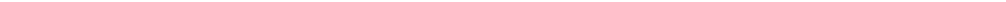
(see fi gure on previous page) Fig. 2 Bivalent chromatin domains in hPGCs. a Heatmaps showing the distribution of H3K4me3 (red) and H3K27me3 (blue) pro fi les around TSS (± 2 kb) in male and female hPGC samples at early and late stage. Signals are sorted by H3K4me3 pro fi les at each stage and colors indicated ChIP-seq RPM. b Line plots showing the global dynamics of H3K4me3 and H3K27me3 covered promoters in male and female hPGC samples at indicated time points. c Left, immuno fl uorescence analysis for H3K27me3 in male and female genital ridge cryosections at indicated time points. The nuclei of c-KIT positive hPGCs are indicated by white dotted line. Scale bars, 10 μ m. Right, analysis of relative intensity of H3K27me3 between indicated samples. Each dot represents the relative fl uorescence intensity of a single nucleus. Data are represented as the means ± SEM ( n ≥ 18 single nuclei). d Magni fi ed immuno fl uorescence images showing female hPGCs enriched with strong punctuated H3K27me3 signals. The nuclei of individual c-KIT positive hPGCs are marked by white dotted line. e Pie plots showing the proportion of bivalent (green) and H3K27me3-only (blue) promoters within all the H3K27me3 covered promoters in hPGC samples of both sexes at early and late stage. f Boxplots showing the H3K4me3 pro fi les and gene expression levels on promoters with (w/) and without (w/o) H3K27me3 enrichment at early and late stage of male and female hPGCs. H3K4me3 signals at H3K27me3 covered promoters were much higher than those at non-H3K27me3 covered promoters. And genes covered by H3K27me3 signals showed a much lower expression level. Expression levels are represented as FPKM and pro fi les are calculated as ChIP-seq RPM. g Genome browser view of H3K4me3 and H3K27me3 pro fi les (shaded in light purple) on representative bivalent gene SYCP1 of both sexes at early and late stage. Pro fi les are calculated as ChIP-seq RPM and smoothed as 3 pixels window using WashU Epigenome Browser. h Barplot showing SYCP1 expression in hPGCs of both sexes at early and late stage. i Barplot showing the number of bivalent promoters in hPGCs of both sexes at indicated time points, gonadal somatic cells and hESCs. Data of hESCs is cited from GSE29611. j Sources of gained bivalent genes from previous stage to present stage in male and female hPGC samples. For male, Wk8 – 10 and Wk23 hPGC samples are represented as early and late stage, respectively; for female, Wk8 – 10 and Wk21 hPGC samples are represented as early and late stage, respectively. Soma, gonadal somatic cells, F female, M male. Student ’ s t test is performed to examine the signi fi cant statistical difference between two groups of data in ( c and f ). * P < 0.05, ** P < 0.01, *** P < 0.001, n.s. not signi fi